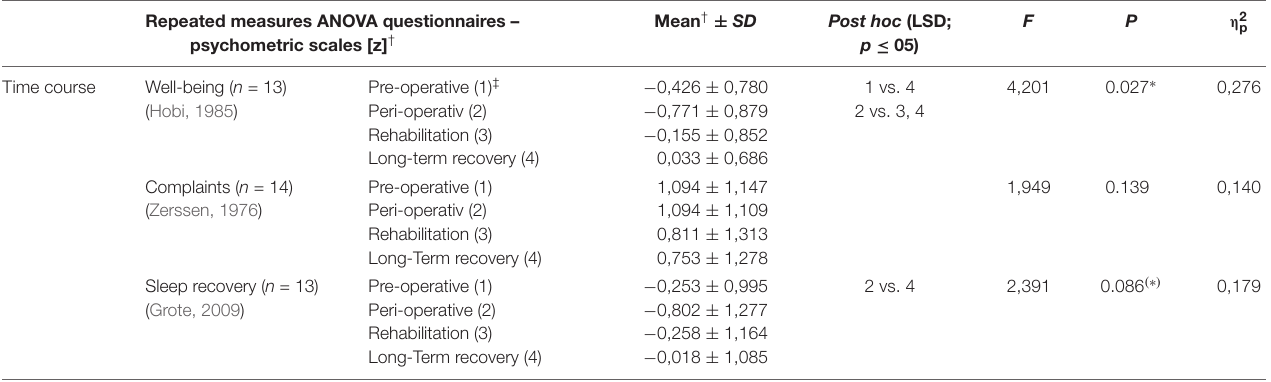
TABLE 5 | Statistics and Questionnaires. Repeated measures ANOVA questionnaires – psychometric scales [z]